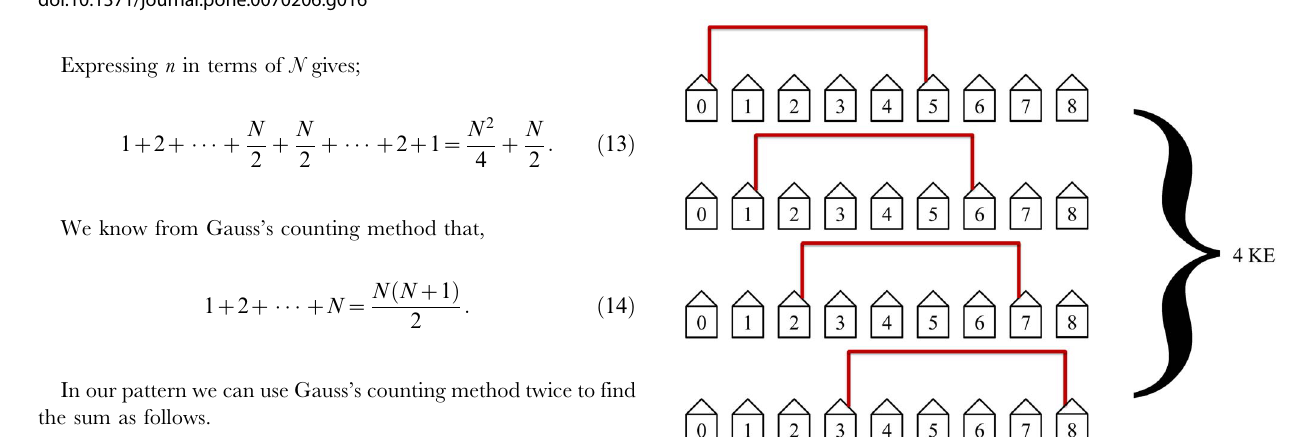
Figure 16. The third step in the protocol connects the third nearest neighbors. This step requires 3 KEs to complete.